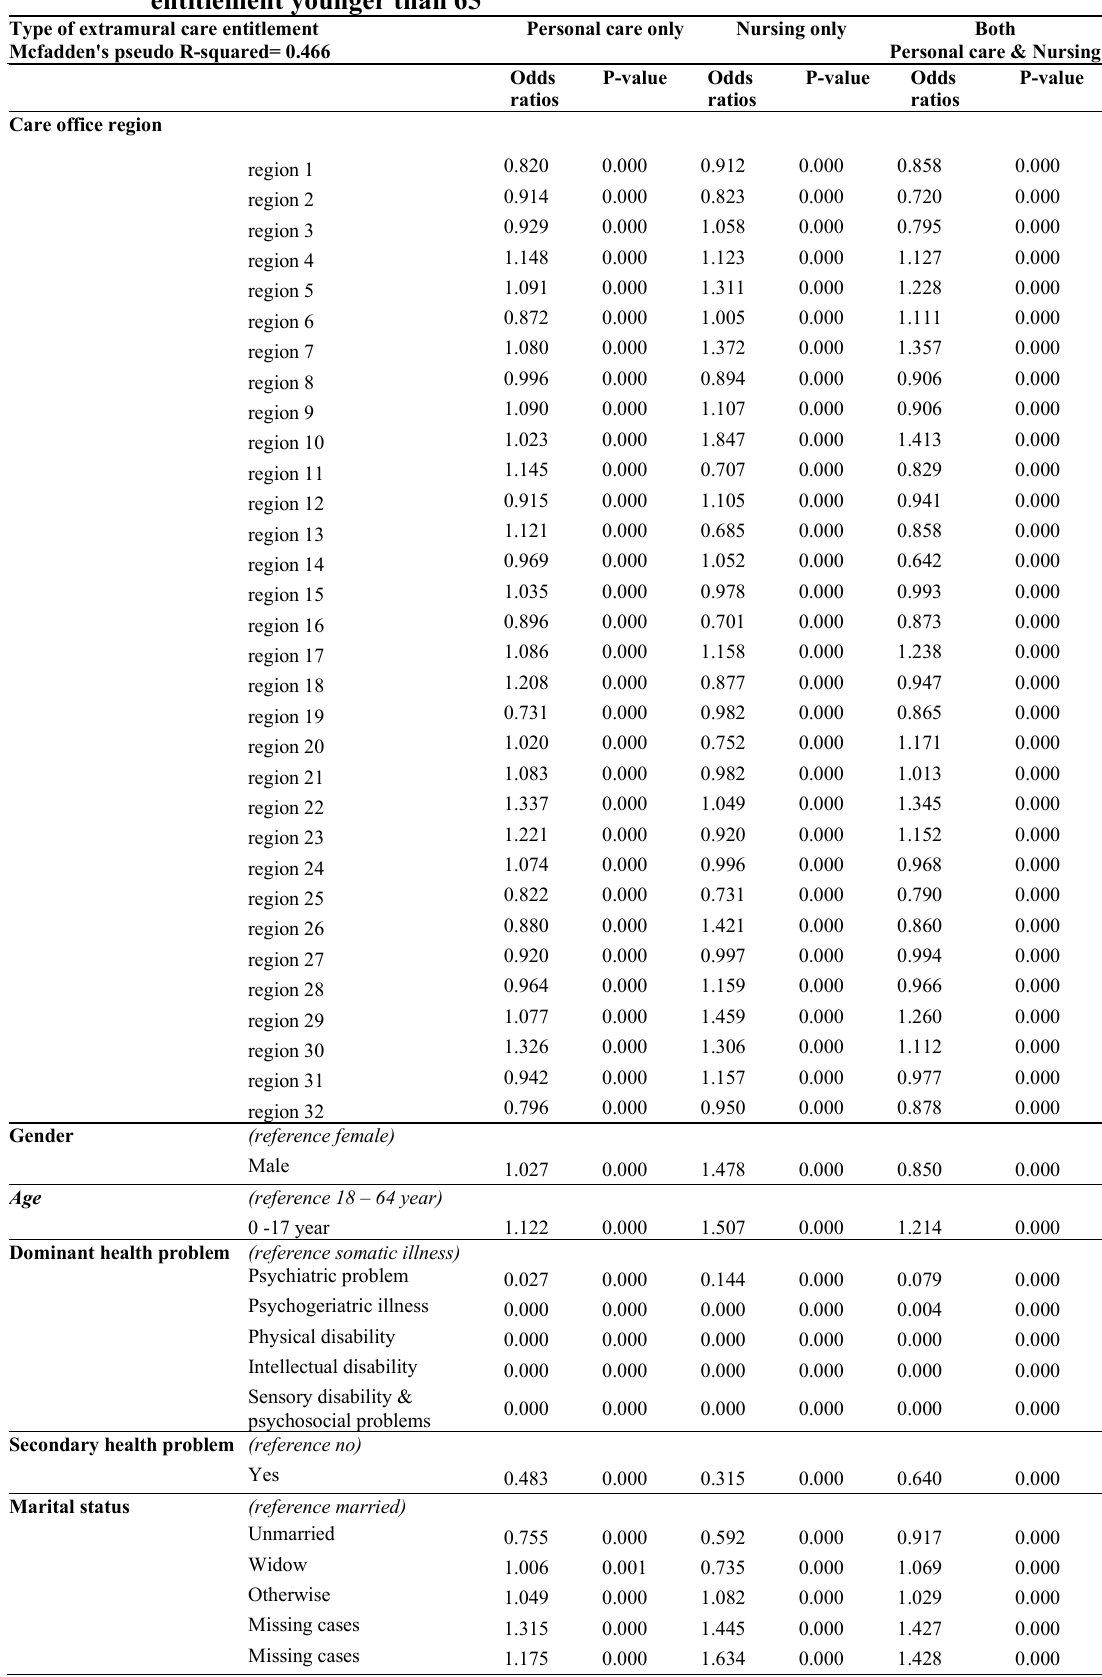
Table 3.2: Model 1 multinomial logistic model for the probability of an home care entitlement younger than